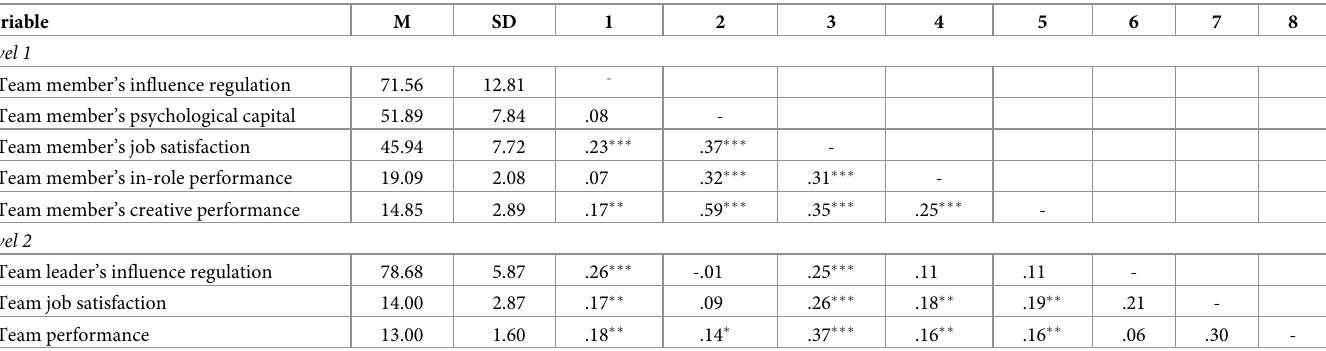
Note . Spearman correlation coefficient is used. N = 309 individuals (level 1) in 34 groups (level 2), except for group-level correlations among team leader’s influence regulation, team job satisfaction and team performance ( N = 34).